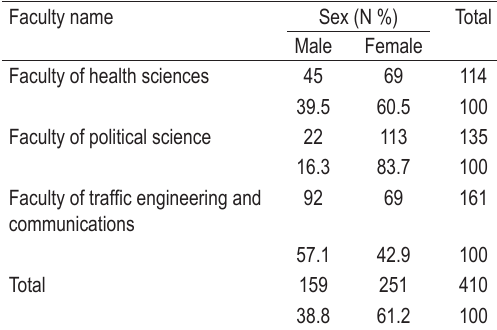
FIGURE 2. Prevalence of cigarette smoking and alcohol con‑ sumption among students from three faculties of the University of Sarajevo. TABLE 1. Male to female ratio of students in three